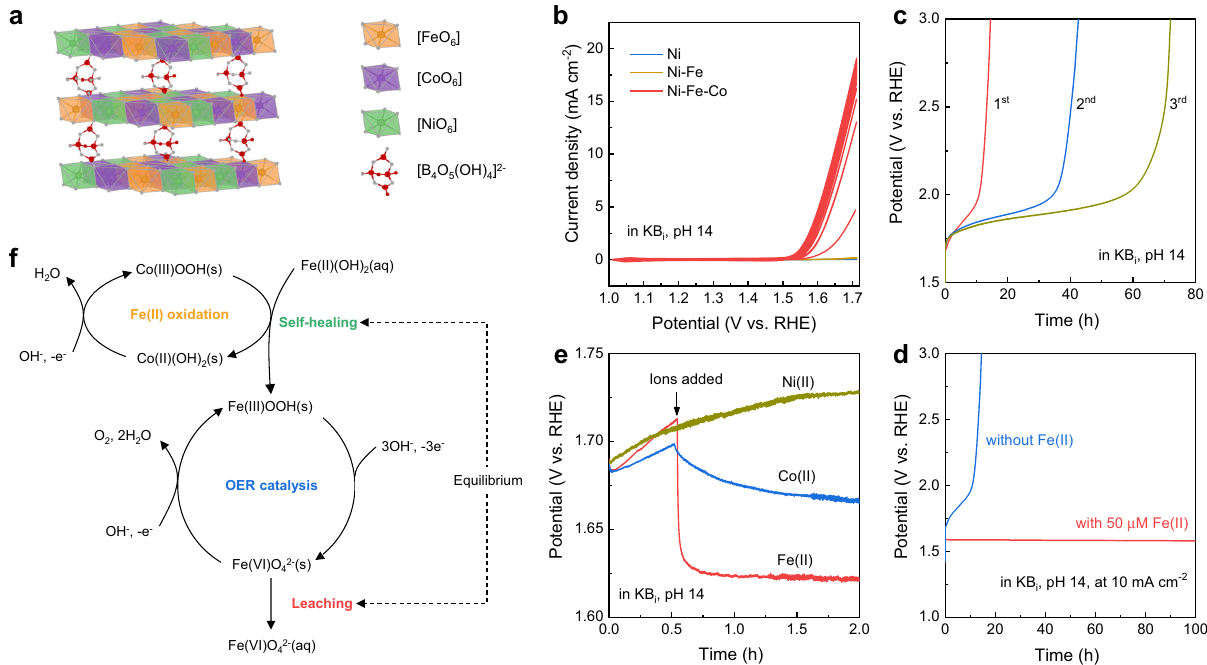
Fig. 2 The demonstration of a NiCoFe-B i catalyst with self-healing ability. a Schematic structure of the NiCoFe-B i catalyst. The basal layers are composed of mixed [FeO 6 ], [CoO 6 ], and [NiO 6 ] octahedral sites and are intercalated with [B 4 O 5 (OH) 4 ] 2 − ions. b In situ sequential deposition of metal oxyhydroxides on FTO substrate. 50 μ M of Ni(II), Fe(II), and Co(II) ions were sequentially added to the KB i electrolyte at pH 14. After the addition of each ion, 20 cyclic voltammetry (CV) scans were performed between 1.01 and 1.71 V vs. RHE with a scan rate of 50 mV s − 1 . c Chronopotentiometric curves of three NiCoFe-B i catalyst fi lms measured sequentially in the same KB i electrolyte at pH 14 under constant current density of 10 mA cm − 2 . d Comparison of the stability of NiCoFe-B i catalyst in KB i electrolyte with and without adding Fe(II) ions. e Chronopotentiometric curves of NiCoFe-B i catalyst fi lms measured in KB i electrolyte at pH 14 with 30 μ M Ni(II), Co(II), or Fe(II) ions added after 0.5 h, respectively. f The proposed Co-catalyzed self-healing mechanism of the NiCoFe-B i